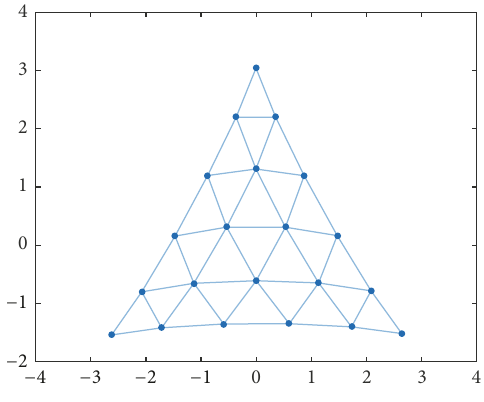
Figure 3: Triangular oxide network